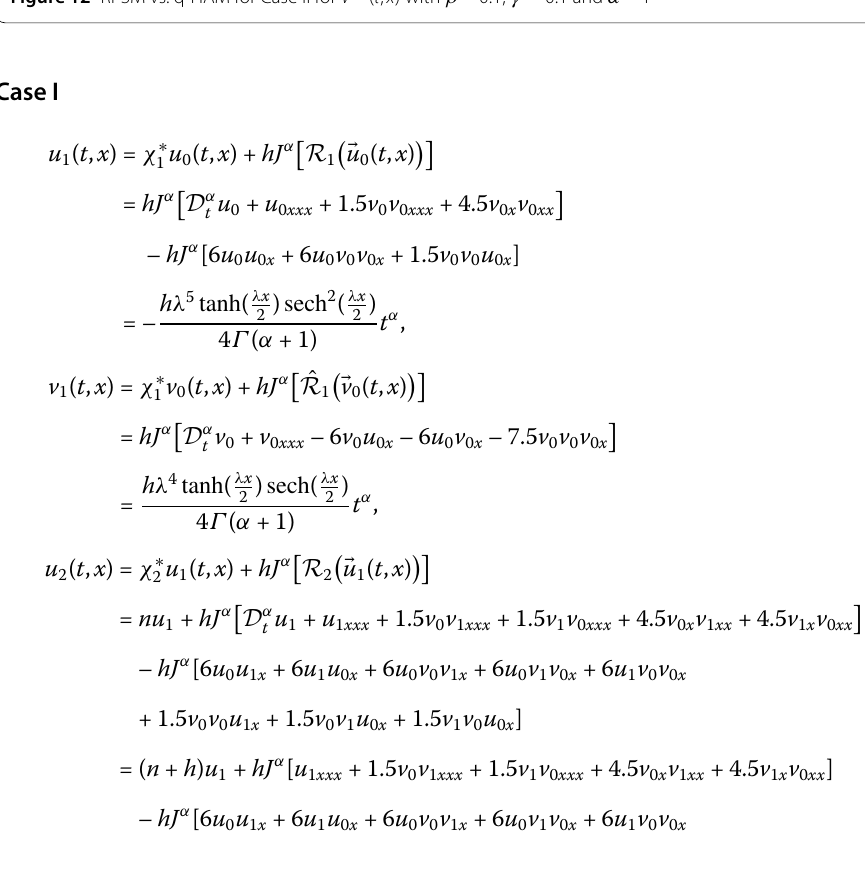
Figure 12 RPSM vs. q-HAM for Case II for V (2) ( t , x ) with β = 0.1, γ = 0.1 and α = 1